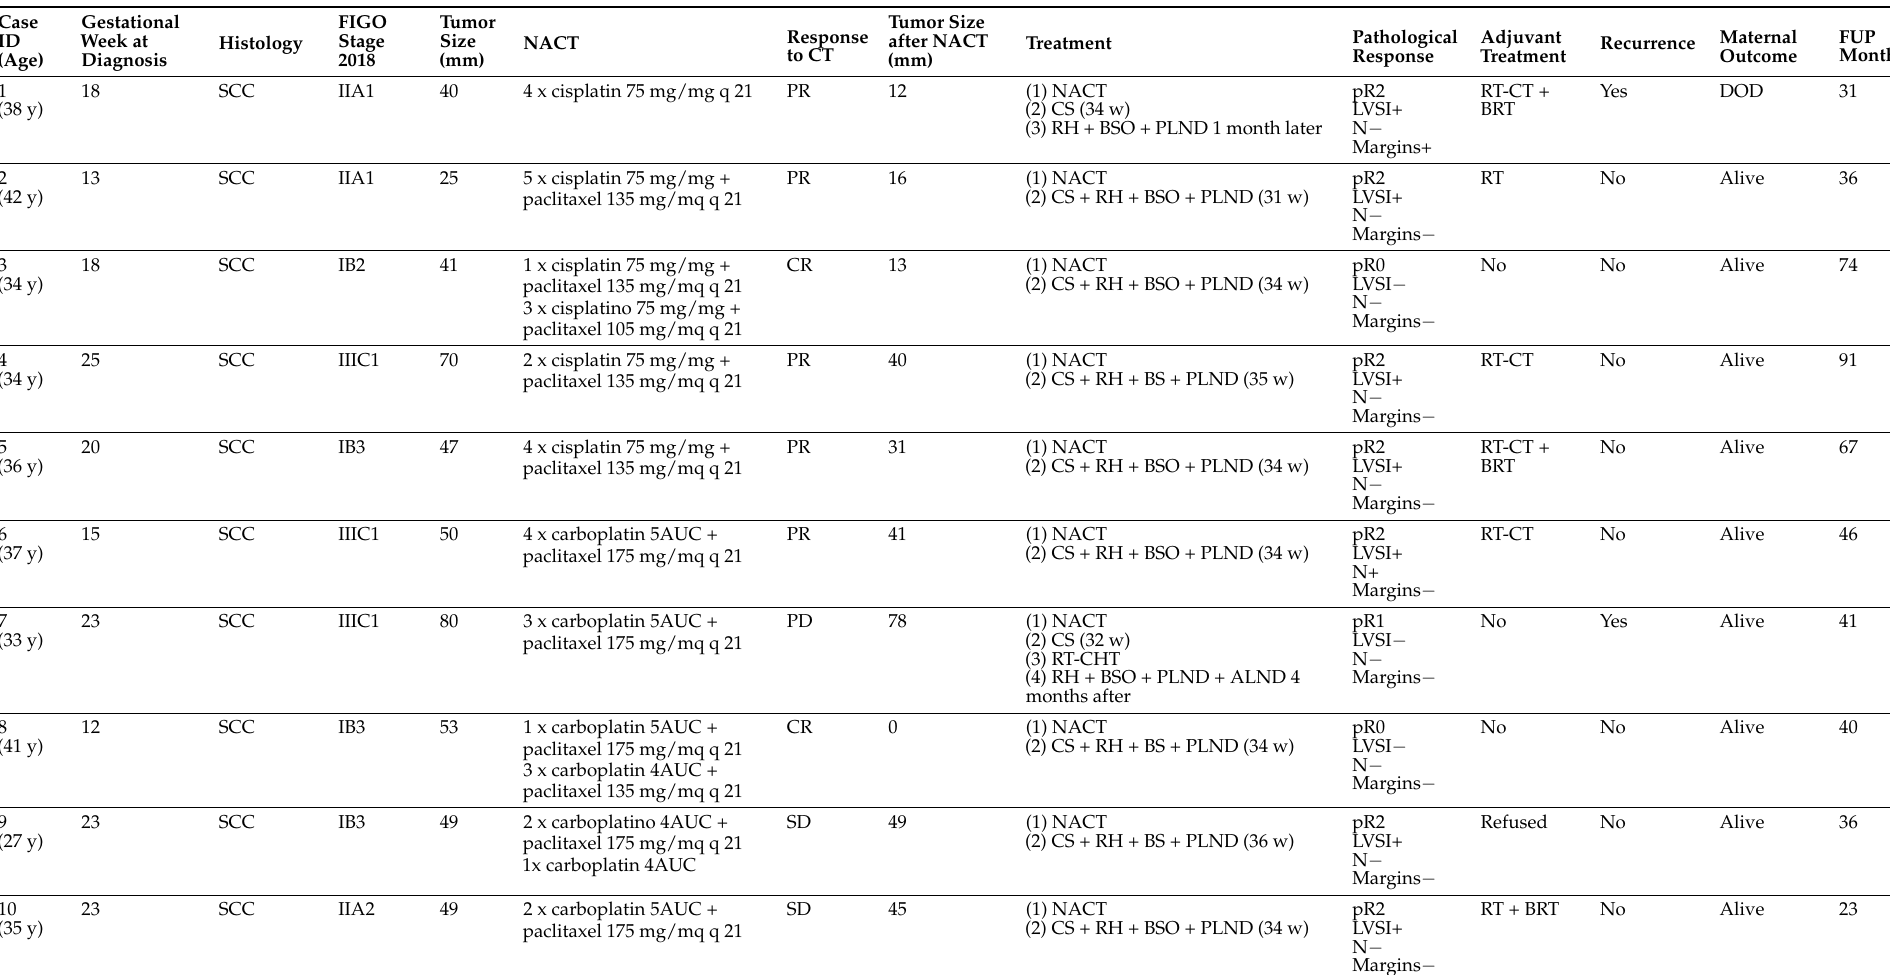
Table 1. Clinical and pathological features of the study